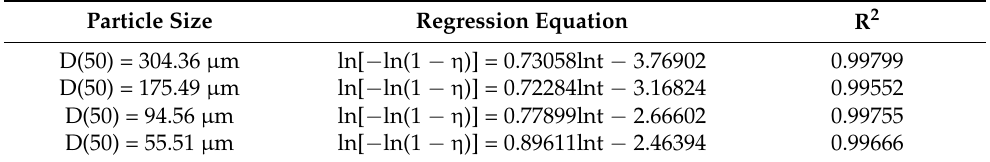
Figure 10. Plots of ln[ − ln(1 − η )] vs. lnt in alkali fused SCC leaching process under different particle sizes. Table 2. Fitting results between ln[ − ln(1 − η )] and lnt under different particle size. Particle Size Regression Equation R